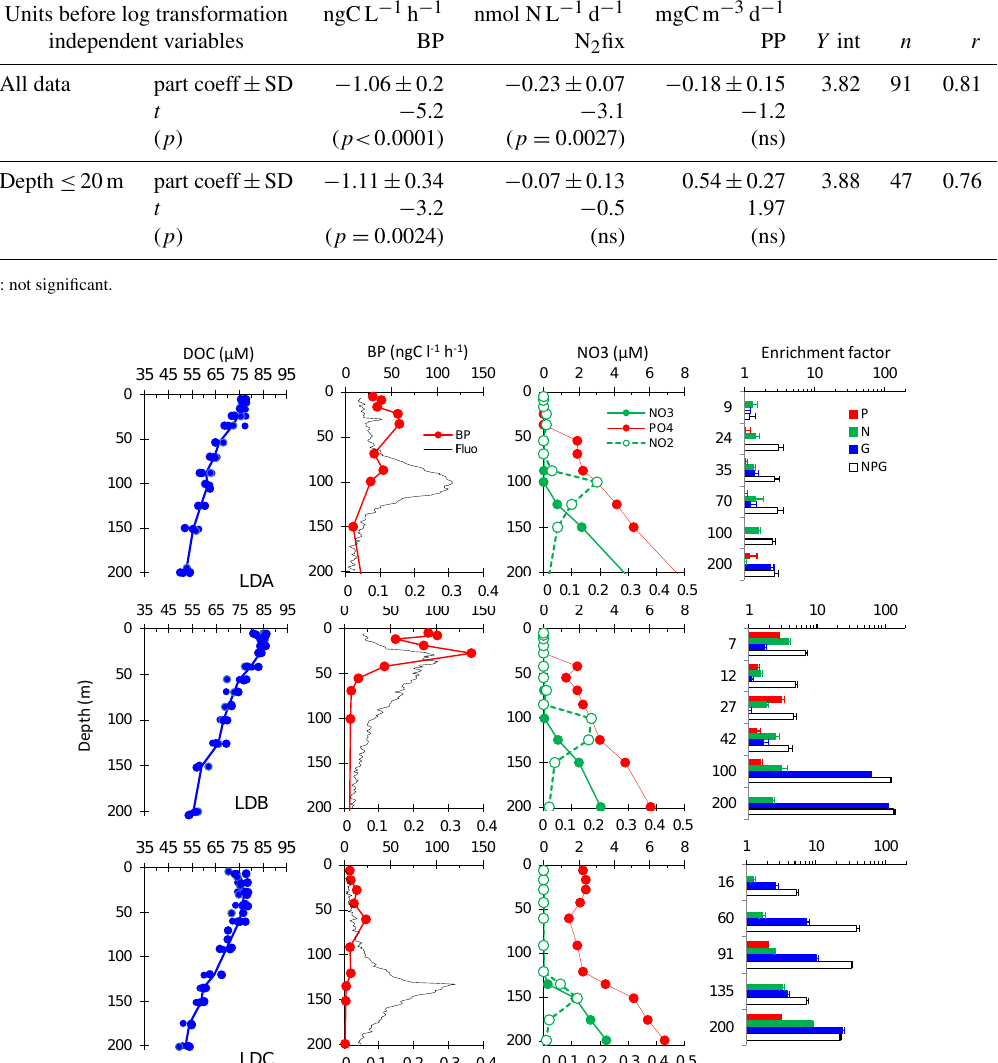
eas or within upwelling areas in the east, are scarce (Table